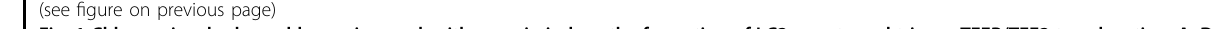
Fig. 1 Chloroquine, hydroxychloroquine, and azithromycin induce the formation of LC3 puncta and trigger TFEB/TFE3 translocation. A – D Human osteosarcoma U2OS-GFP-LC3 ( A , B ) or human glioma H4-GFP-LC3 cells ( C , D ) were treated with chloroquine (CQ; 10, 20, 40 μ M), hydroxychloroquine (HCQ; 10, 20, 40 μ M), azithromycin (AZT; 10, 20, 40 μ M), the autophagy inducer torin 1 (TOR; 300 nM), or the inhibitor of autophagic fl ux ba fi lomycin A1 (BafA1; 100 nM) for 6 h. After fi xation, healthy cells depicted by normal nuclear morphology were enumerated. Representative microscopical images are shown in A and C (AZT, CQ, and HCQ, 40 µM) and normalized mean data are depicted as bar charts in B and D . Data are means ± SD of four replicates (* P < 0.05, ** P < 0.01, *** P < 0.001 vs. vehicle control (Ctrl); Student ’ s t -test). E , F U2OS-GFP-LC3 wild type or ATG5 knockout (KO) cells were treated with CQ, HCQ, or AZT (all at 10, 20, 40 μ M), TOR (300 nM), and BafA1 (100 nM) for 6 h. After fi xation, GFP-LC3 dots were analyzed as a proxy for autophagy induction. Representative microscopical images are shown in E (AZT, CQ, and HCQ, 40 µM) and normalized mean data are depicted as bar chart in F . Data are means ± SD of four replicates (** P < 0.01, *** P < 0.001 vs. vehicle control (Ctrl), and ### P < 0.001 vs. WT; Tukey ’ s multiple comparisons test). G , H U2OS cells stably expressing GFP-TFEB fusion protein were treated with CQ, HCQ, or AZT (all at 0.1, 0.3, 1, 3, 10, 30 μ M) for 6 h. TOR at 300 nM was used as a positive control for TFEB nuclear translocation. Images were analyzed and the ratio of GFP intensities in nuclei and cytoplasm was calculated to indicate TFEB translocation to nuclei ( H ). Representative images are depicted in G (AZT, CQ, and HCQ, 30 µM). I , J U2OS cells were treated as above, and then TFE3 translocation was assessed microscopically after immunostaining ( I ). TOR at 300 nM was used as a positive control for TFE3 nuclear translocation. TFE3 intensities in the nucleus and the cytoplasm were measured, and the nucleo-to-cytoplasmic ratio of TFE3 intensities was calculated to indicate nuclear translocation of TFE3 ( J ). Data are means ± SD of four replicates (* P < 0.05, ** P < 0.01, *** P < 0.001 vs. Ctrl, Student ’ s t -test). Scale bars equal 10 μ